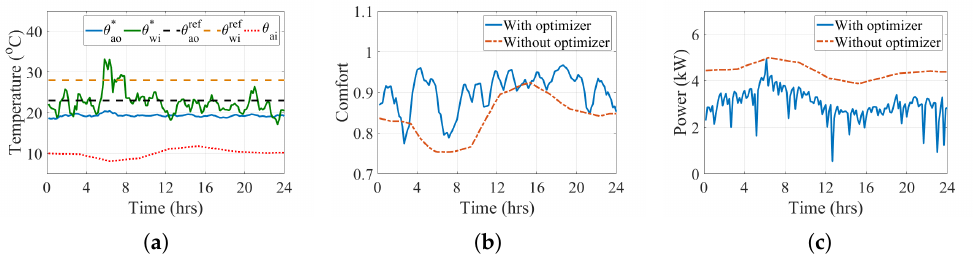
Figure 12. System performance during typical cool day in Auckland (first day of June). ( a ) Optimized set points. ( b ) Comfort level comparison. ( c ) AHU system power consumption for temperature